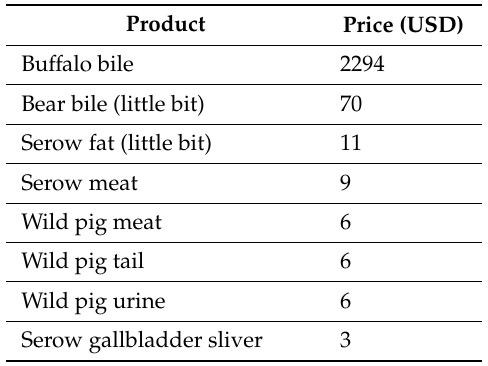
Table 3. Average prices of wild animal products given by the sample (total n =